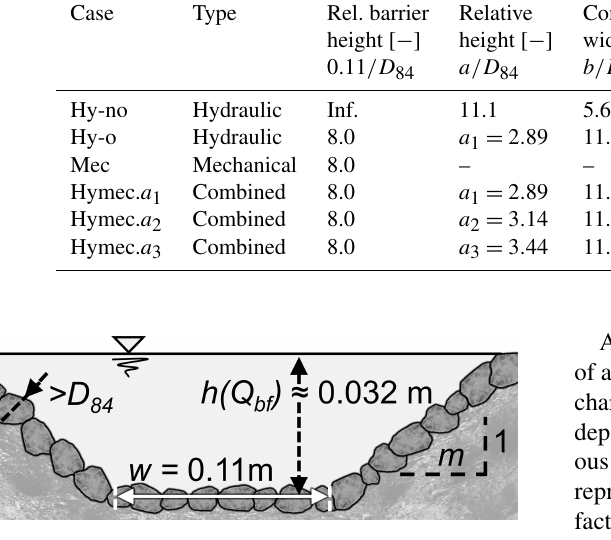
Figure 5. The cross section of the trapezoidal guiding channel, lined with fixed grains larger than the D 84 of the sediment supply mix- ture and designed for bank overtopping for discharges higher than 5.5Ls − 1